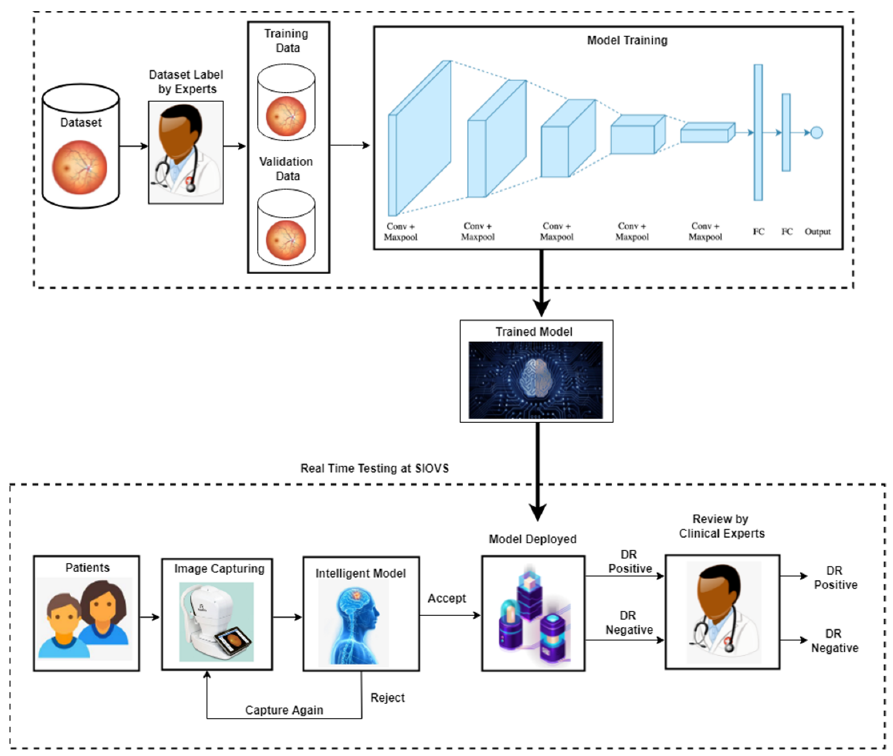
Figure 2. Diabetic Retinopathy detection architecture.